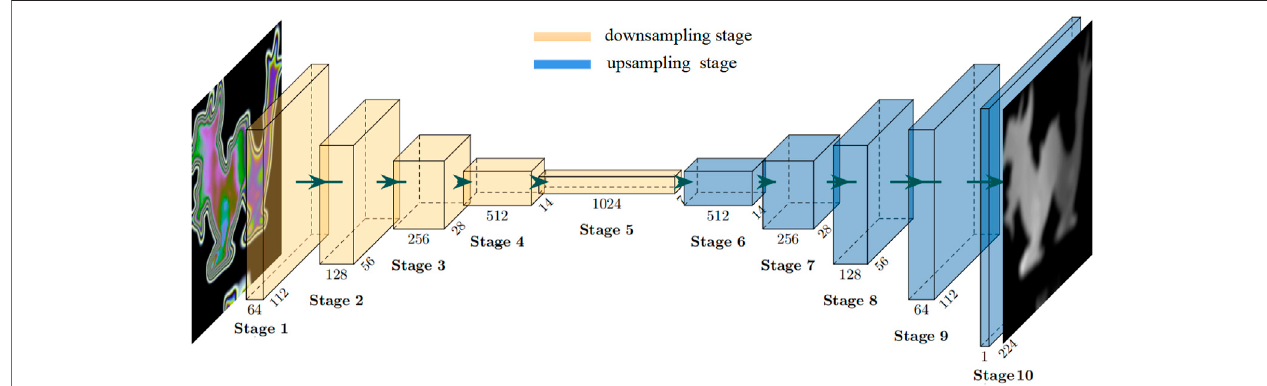
FIGURE 2 | Schematic for the neural network architecture of the proposed model in this research. The network consists of an encoder and a decoder. An RGB isochromatic image is taken as the input, and the output is a stress map in gray scale.